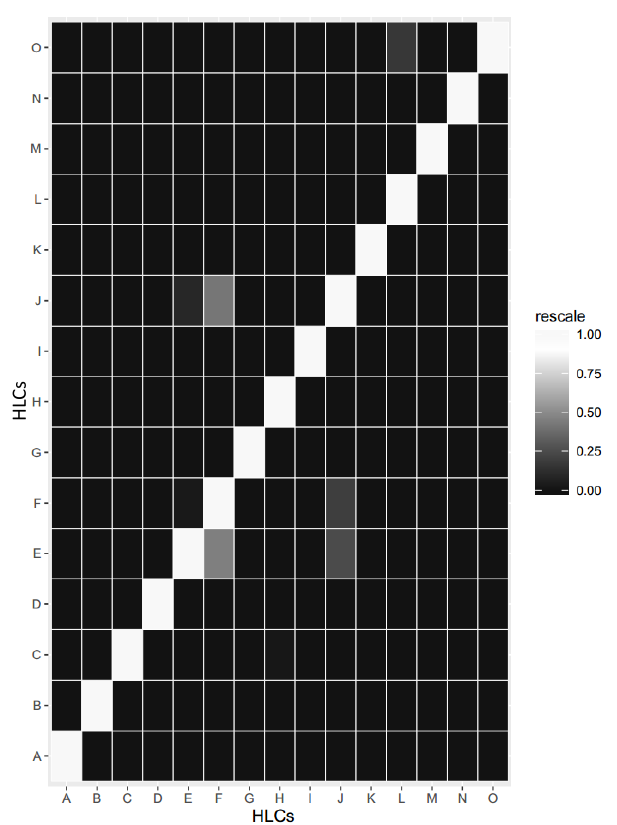
Figure 13. Confusion Matrix expressed as heat map for recognized HLCs (PA-HLC, N-HLC, and C-HLC). Legend: A = Amusement, B = Commuting, C = Exercising, D = Gardening, E = Carbohydrate, F = Fats, G = Housework, H = Inactivity, I = OfficeWork, J = Protein, K = Sleeping, L = HighRiskHealthState, M = ModerateRiskHealthState, N = NormalHealthState, O = VeryHighRiskHealthState.